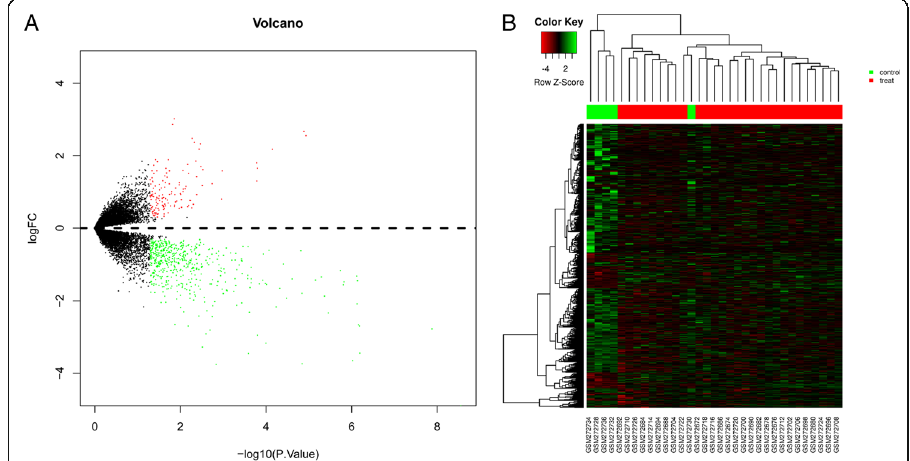
Fig. 2 Heat map and volcano plot for differentially expressed genes (DEGs) in breast cancer stroma cells compared with normal breast stroma from GSE10797. a – Volcano plot of DEGs in breast cancer stroma cells from GSE10797. x-axis: LogFC, large magnitude fold changes; y-axis: -log10 of p -value, high statistical significance. Red and green points: log 2 |fold change| ≥ 1 and p value <0.05. Black points: log 2 |fold change|<1 or p value >0.05. b – Dendrogram of DEGs identified via cluster analysis. Each column represents one sample. The green header indicates normal stromal cells and red indicates breast cancer stromal cells. Each row represents one gene, with red representing high relative expression, and green representing low relative